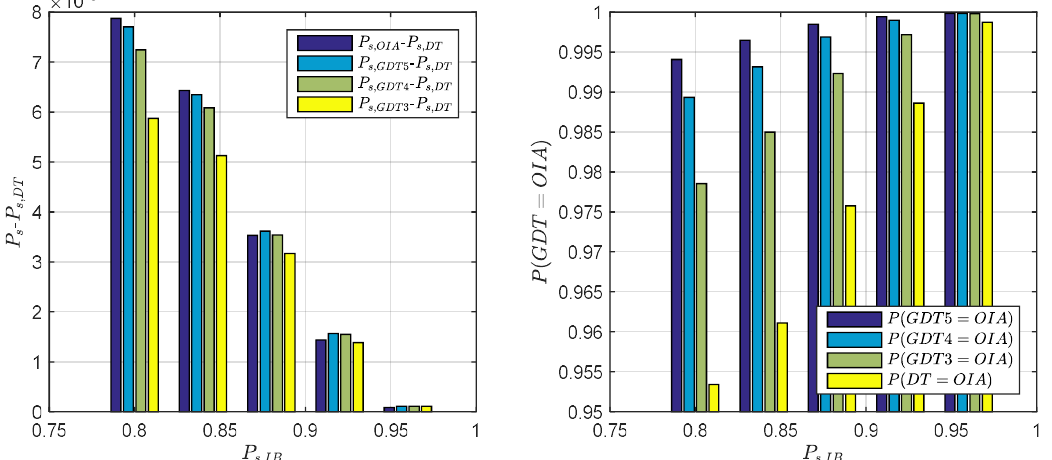
Figure 6. Performance comparison of GDT in terms of success rate gain against DT ( left ) and percentage identical to OIA ( right ).